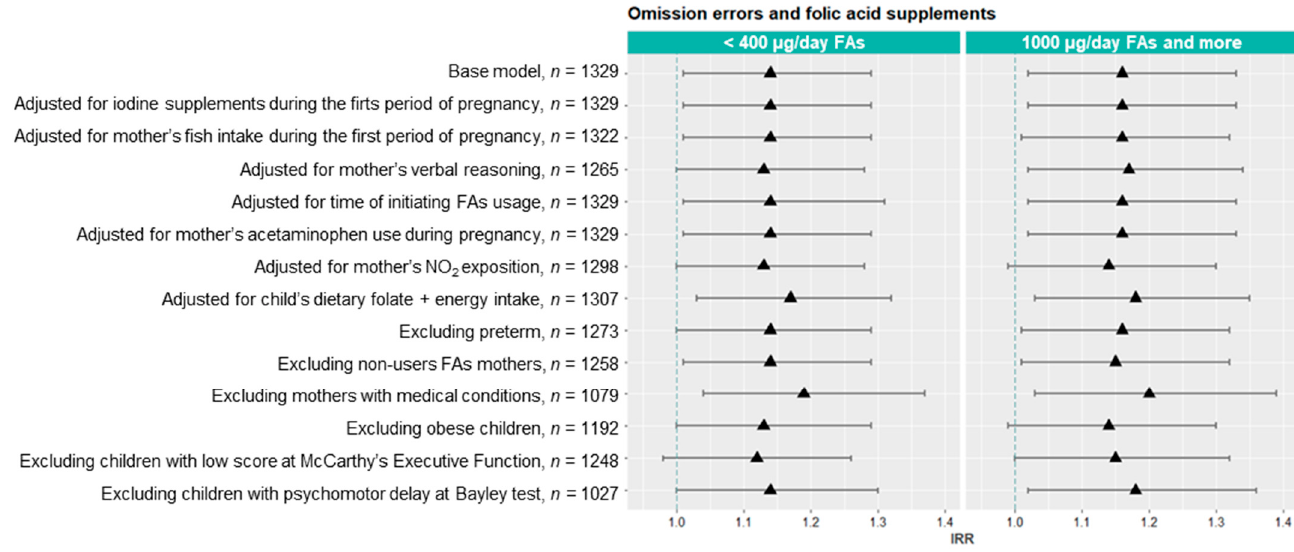
Figure 4. Sensitivity analyses of the associations between FAs use (<400 and ≥ 1000 µ g/day compared to 400–999 µ g/day) in the periconceptional period and number of omission errors in all children ( n = 1329), girls ( n = 665) and boys ( n = 664) at 4–5 years.